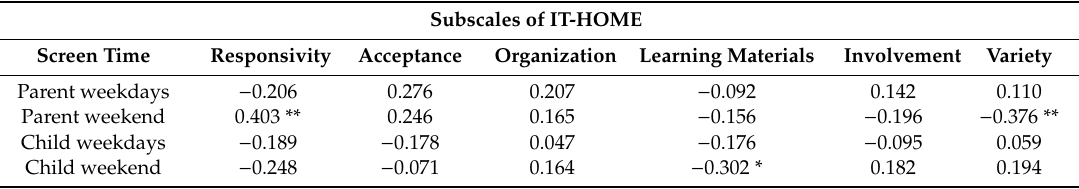
Table 3. Correlation between parental and child screen use and child’s home environment assessed by Infant-Toddler Home Observation for Measurement of the Environment